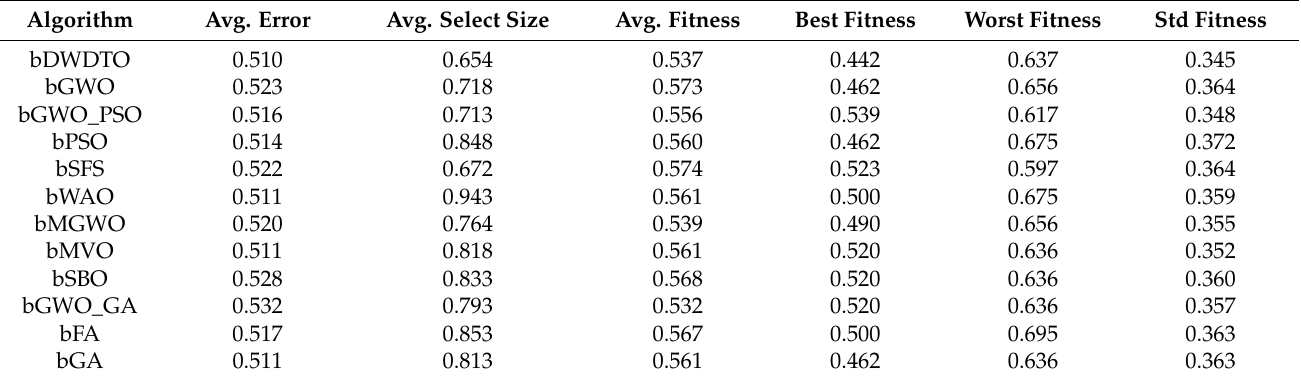
Table 3. Evaluation results of the feature selection results achieved by the proposed algorithm and other competing algorithms when applied to the first dataset